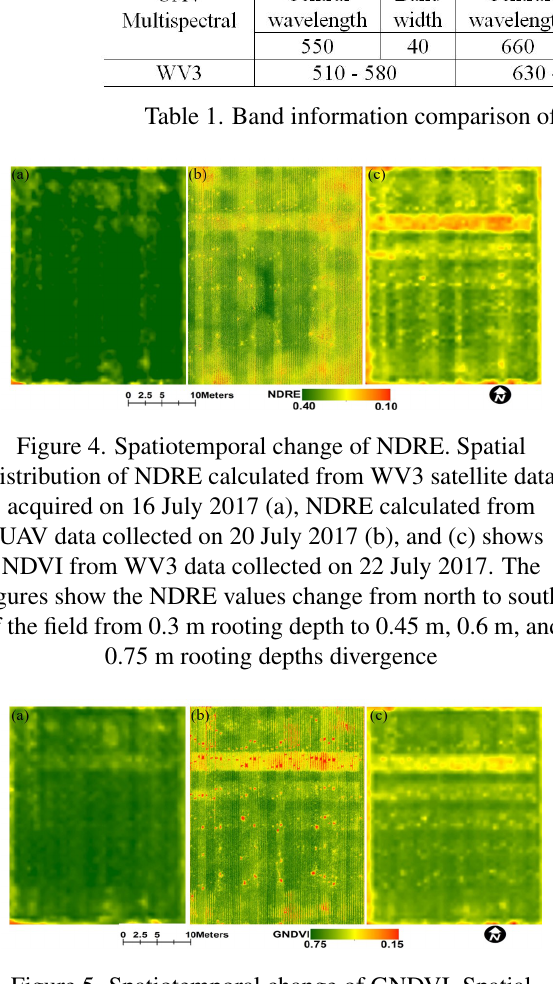
Figure 5. Spatiotemporal change of GNDVI. Spatial distribution of GNDVI calculated from WV3 satellite data